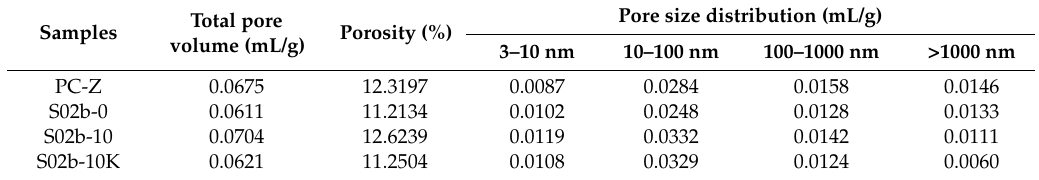
Table 5. Result of mercury intrusion porosimetry (MIP) analysis for cement paste at 56